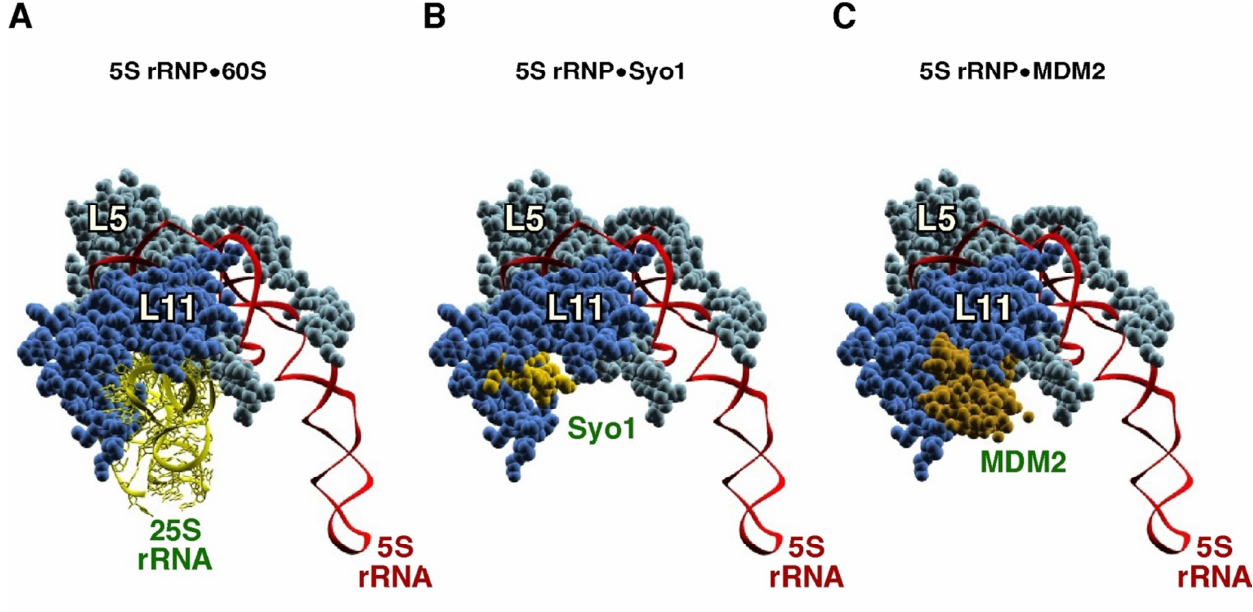
Figure 7: The helix H84 in the 60S r-subunit, the symportin Syo1 and the p53 regulator MDM2 share the same binding site on L11 r-protein. (A) Structure of the 5S RNP as is assembled in the mature 60S r-subunit bound to 25S rRNA (nucleotides 2651-2750 comprising helices H83, H84, H85 and H86). (B) Interaction of a specific region of Syo1, called Syo1-HS (amino acids 328-384), with L11 in the context of the 5S RNP. (C) Structure of the 5S RNP bound to a distinct fragment of MDM2 (amino acids 293-334). The fragment of 25S rRNA is coloured in yellow, that of Syo1 in light gold, and that of MDM2 in dark gold; 5S rRNA in highlighted in red, L5 in cyan and L11 in blue. PDB ID: The 5S RNP bound to 25S rRNA was taken from 3U5I and 3U5H [44]; Syo1-HS fragment was extracted from 5AFF [163] after superimposing the structure shown here with that present in the PDB file 4GMN [144]; MDM2 fragment was taken from 4XXP [164] after superimposing the structure shown in this file with that of L11 shown in